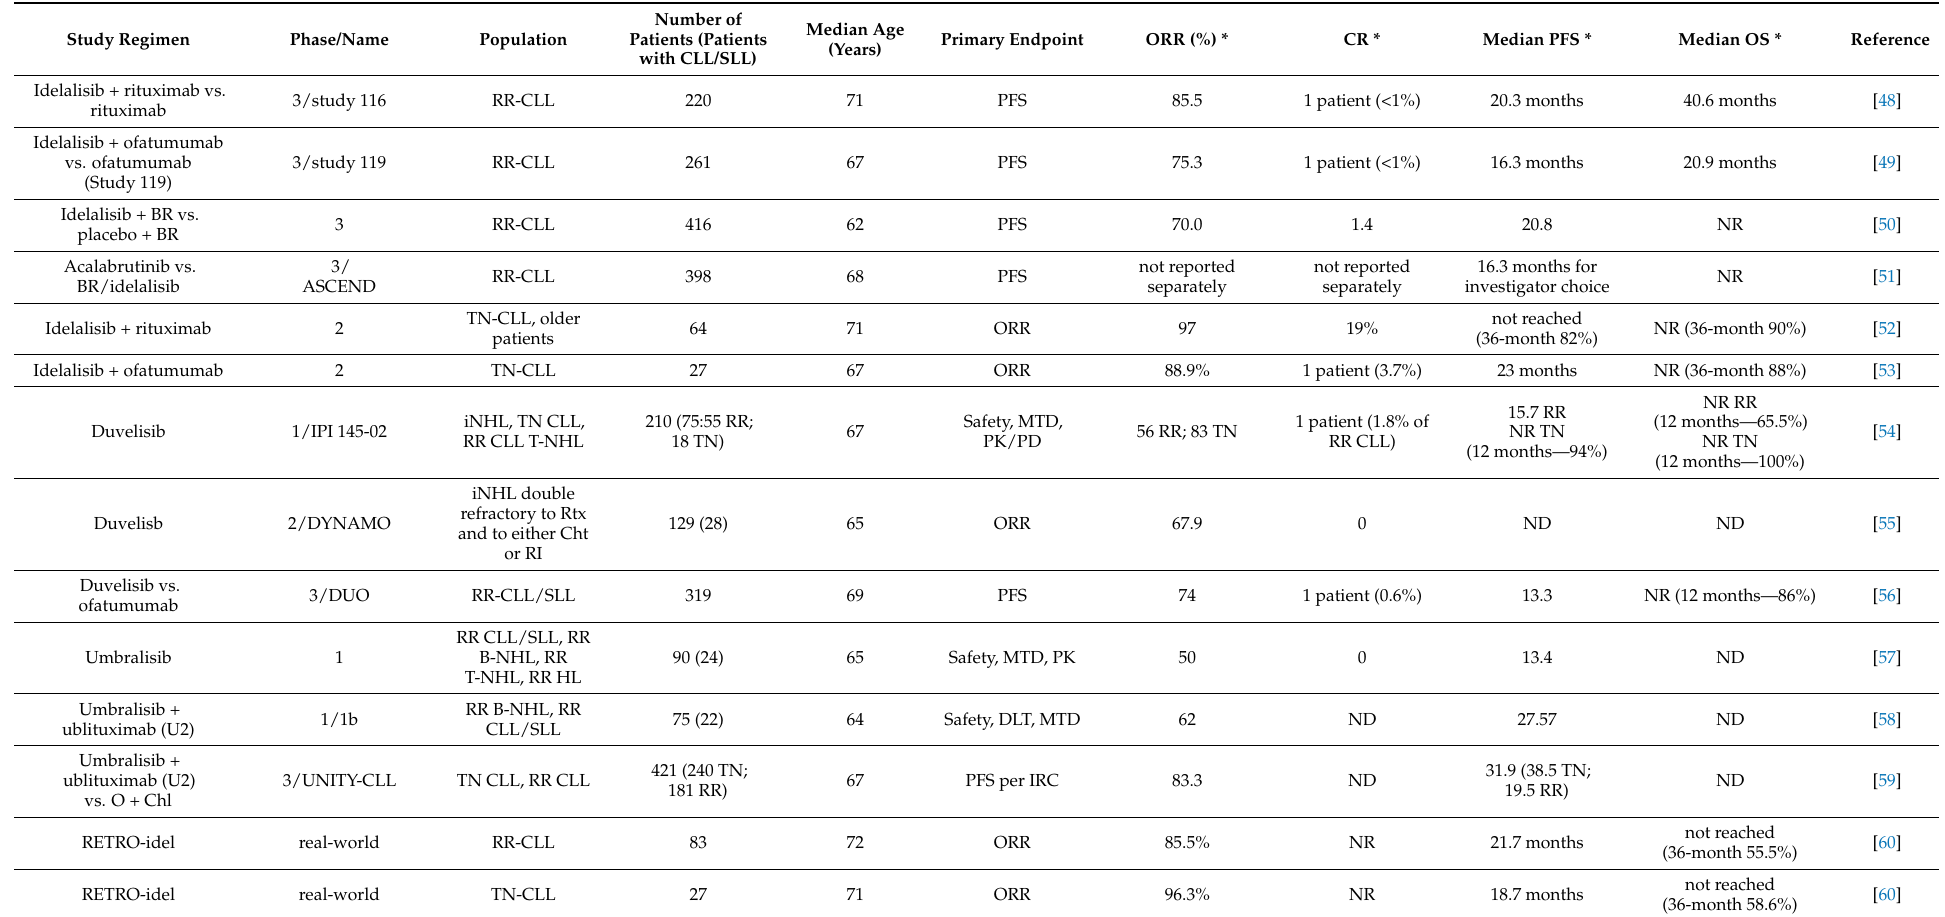
Table 2. Selected clinical studies with PI3Ki in patients with